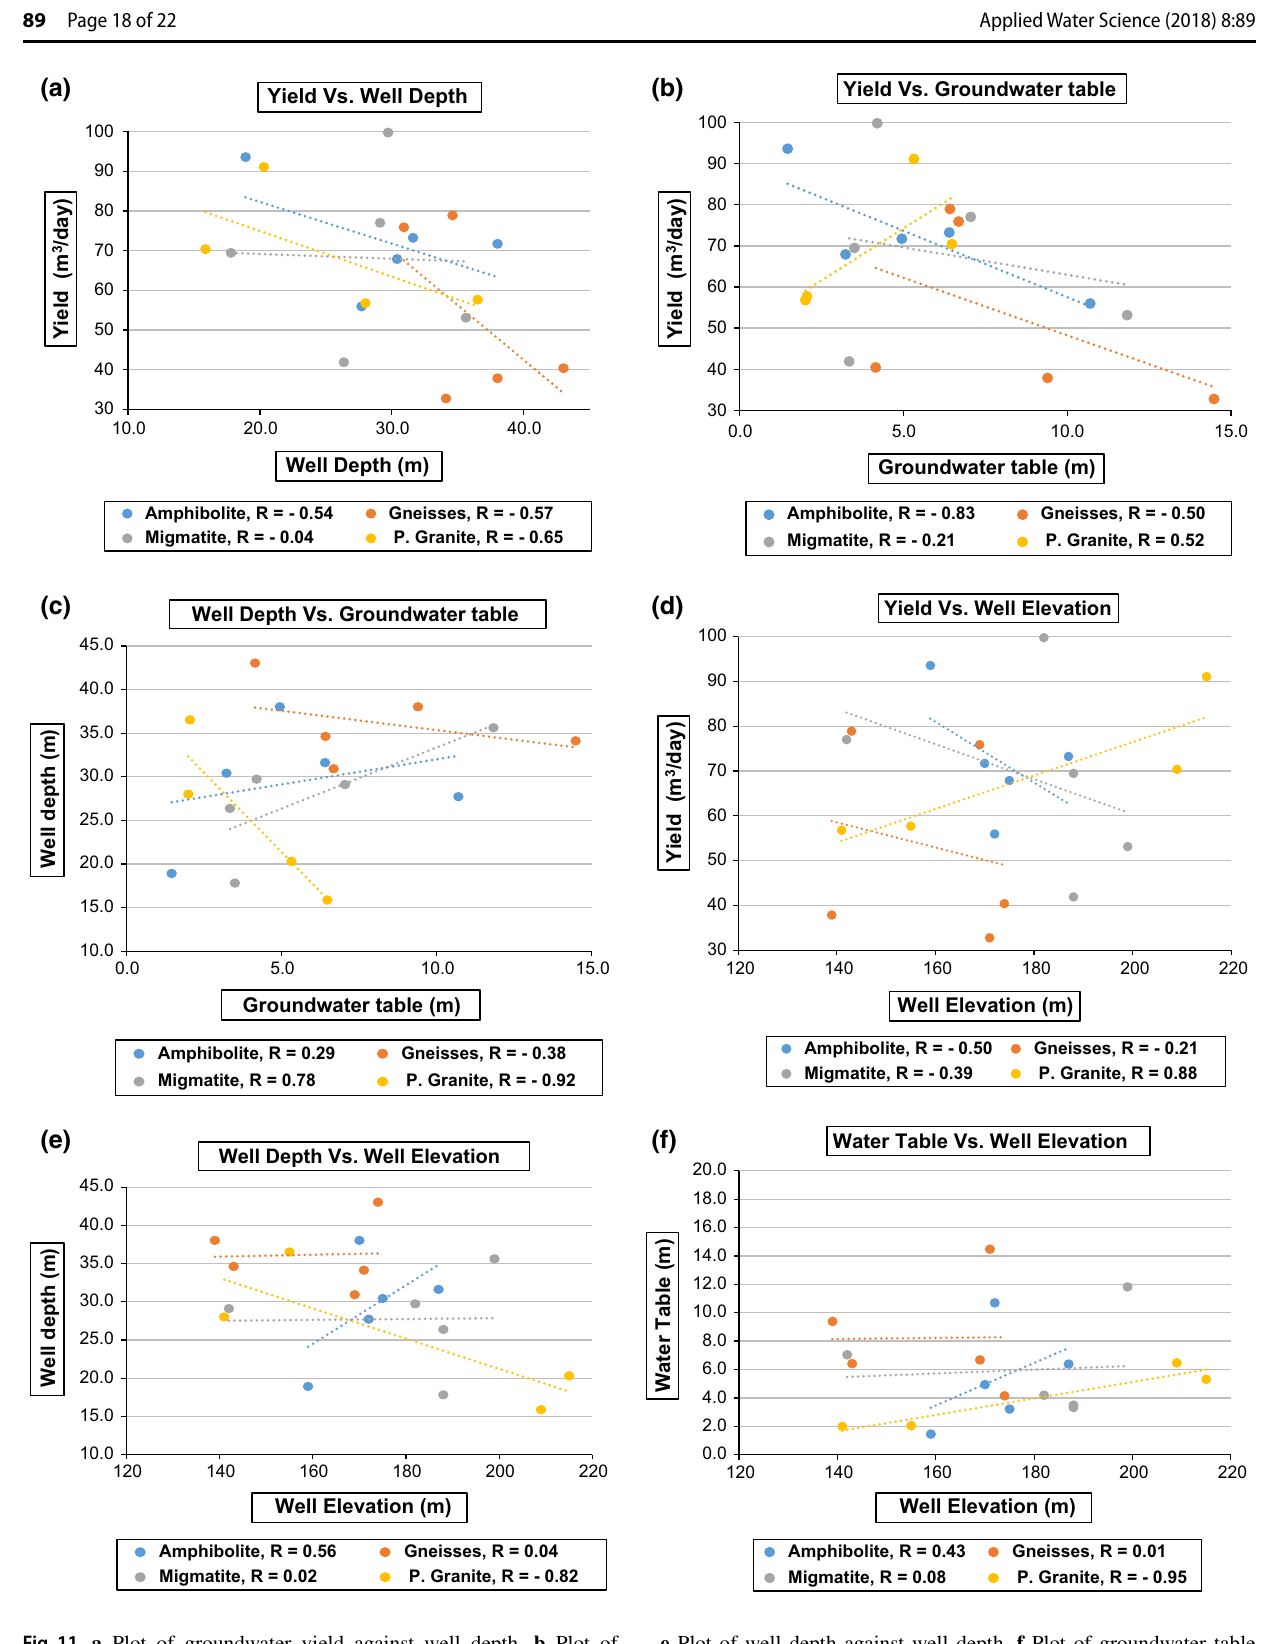
e Plot of well depth against well depth. f Plot of groundwater table against well